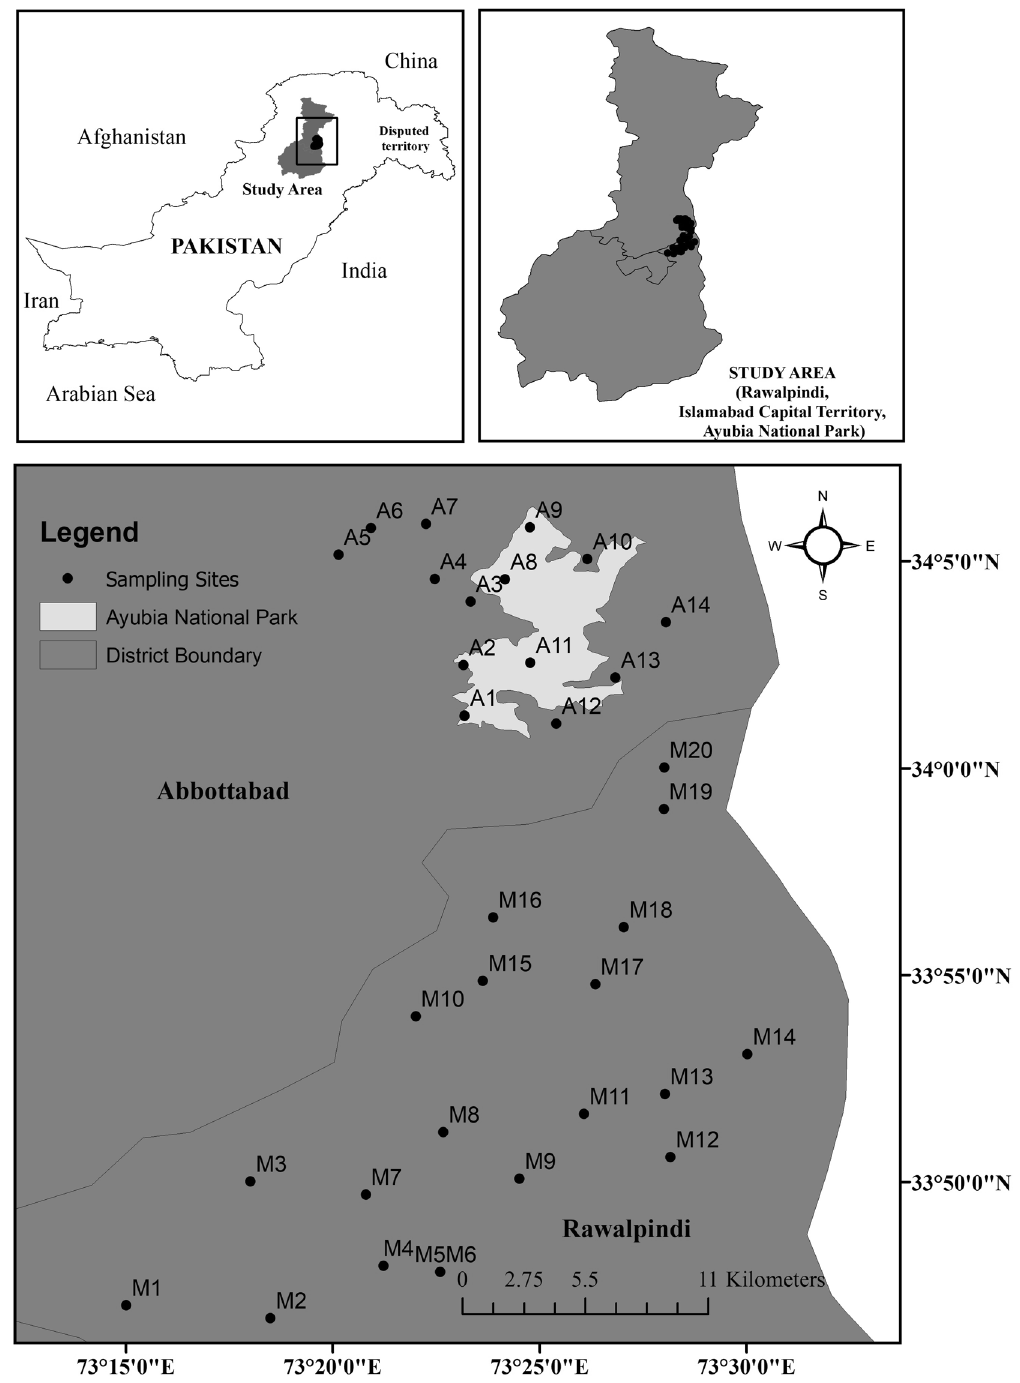
Figure 3. Map of Pakistan indicating study sites of Tehsil Murree (M1–M20), located in the Rawalpindi District, Punjab Province, and those of Ayubia National Park (A1–A14), located in Abottabad Distrct, Khyber Pakhtunkhwa Province. Map generated using ArcMap 10.4.1 (/www. esri. com/ en- us/ arcgis/ produ cts/ arcgis- deskt op/ resou